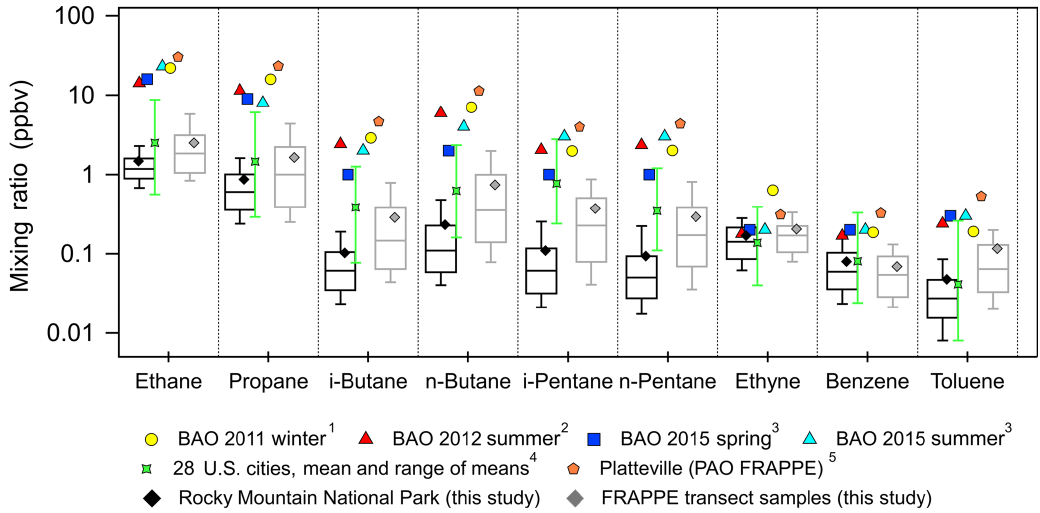
Figure 6. Box plots for mixing ratios of selected VOCs in ROMO hourly samples (black) and all transect canister samples (grey) and mean mixing ratios from previous studies ( 1 Swarthout et al., 2013, 2 McDuffie et al., 2016, 3 Abeleria et al., 2017, 4 Baker et al., 2008, 5 Halliday et al., 2016). Median mixing ratios from this study are shown as the black horizontal lines, the means are shown as the diamond symbols, the top and bottom of the boxes are the 75th and 25th percentiles, and the whiskers are the 90th and 10th percentiles. The error bars on the Baker et al. (2008) data represent the maximum and minimum means observed across the cities. The data from Swarthout et al. (2013) are a mean of hourly canisters collected from noon on 18 February to noon 13 March 2011. The McDuffie et al. (2016) data are a mean of in situ measurements made every 25min from 27 July to 12 August 2012. Abeleria et al. (2017) collected in situ hourly data and the values shown are means. PAO canisters were typically collected 2–3 times a day most days from 17 July to 10 August; the data can be found in NASA Langley’s data repository (https://www-air.larc.nasa.gov/data.htm, last access: 16 August